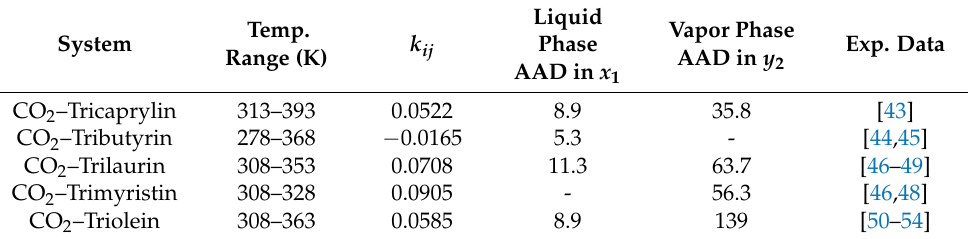
Table 5. Binary parameters and CPA deviations from experimental data CO 2 (1)–glycerides (2).